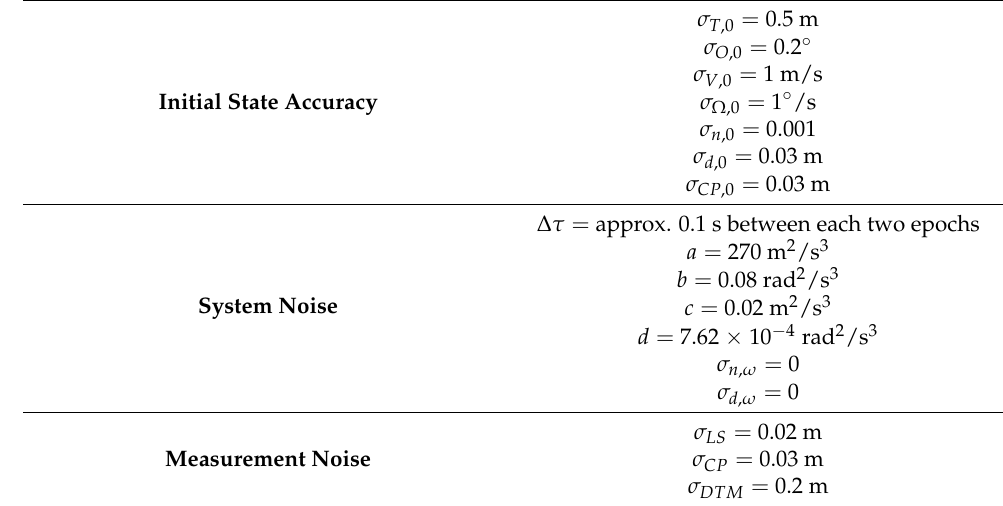
Table 1. Applied accuracy and design parameters ( ˜q ) of the system noise